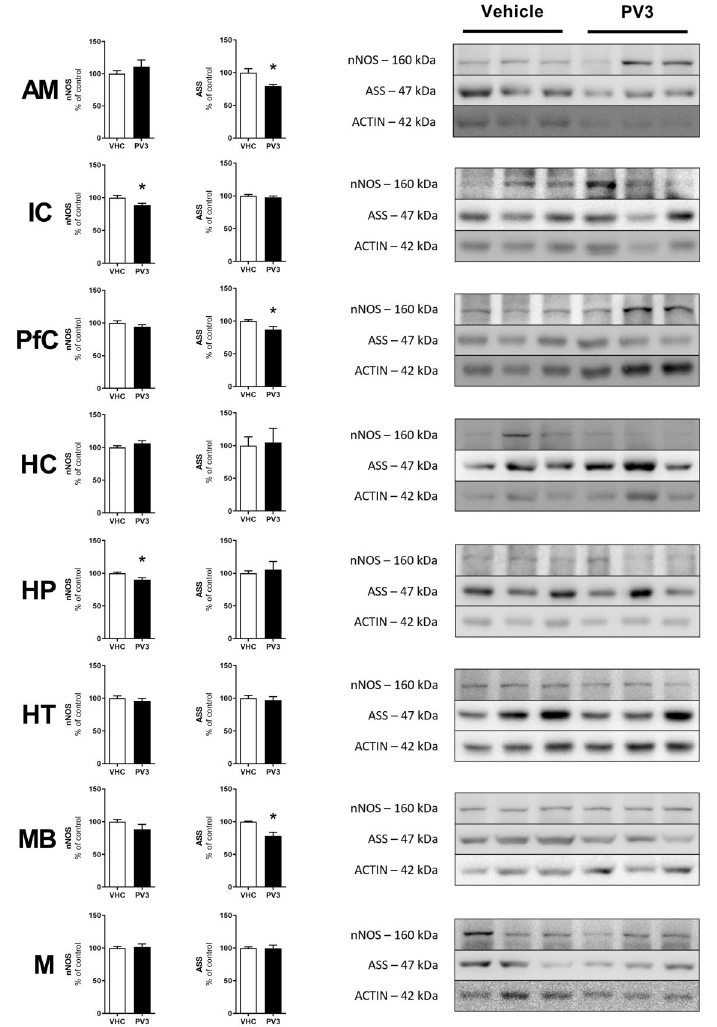
Figure 5. Effect of chronic treatment with Phaseolus vulgaris peptide (PV3) on neuronal nitric oxide synthases (nNOS) and argininosuccinate synthase (ASS) protein expression in different encephalic areas. AM: amygdala, IC: insular cortex, PfC: prefrontal cortex, HC: hippocampus, HP: hypophysis, HT: hypothalamus, MB: midbrain, and M: medulla. Data are reported as means ± SE. *P o 0.05 ( t